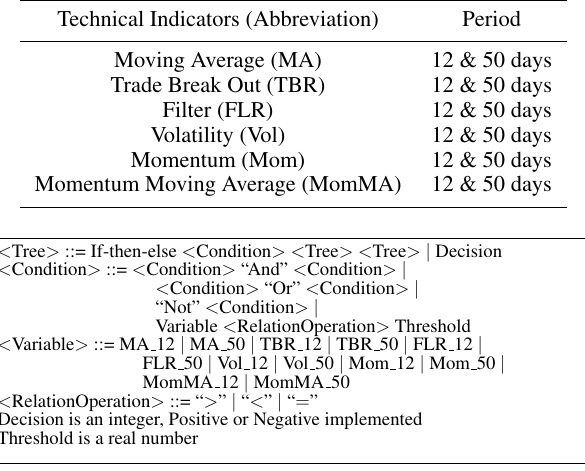
Figure 1 The Backus Naur Form of the EDDIE 7. pends on the user and his belief in their relevance to the